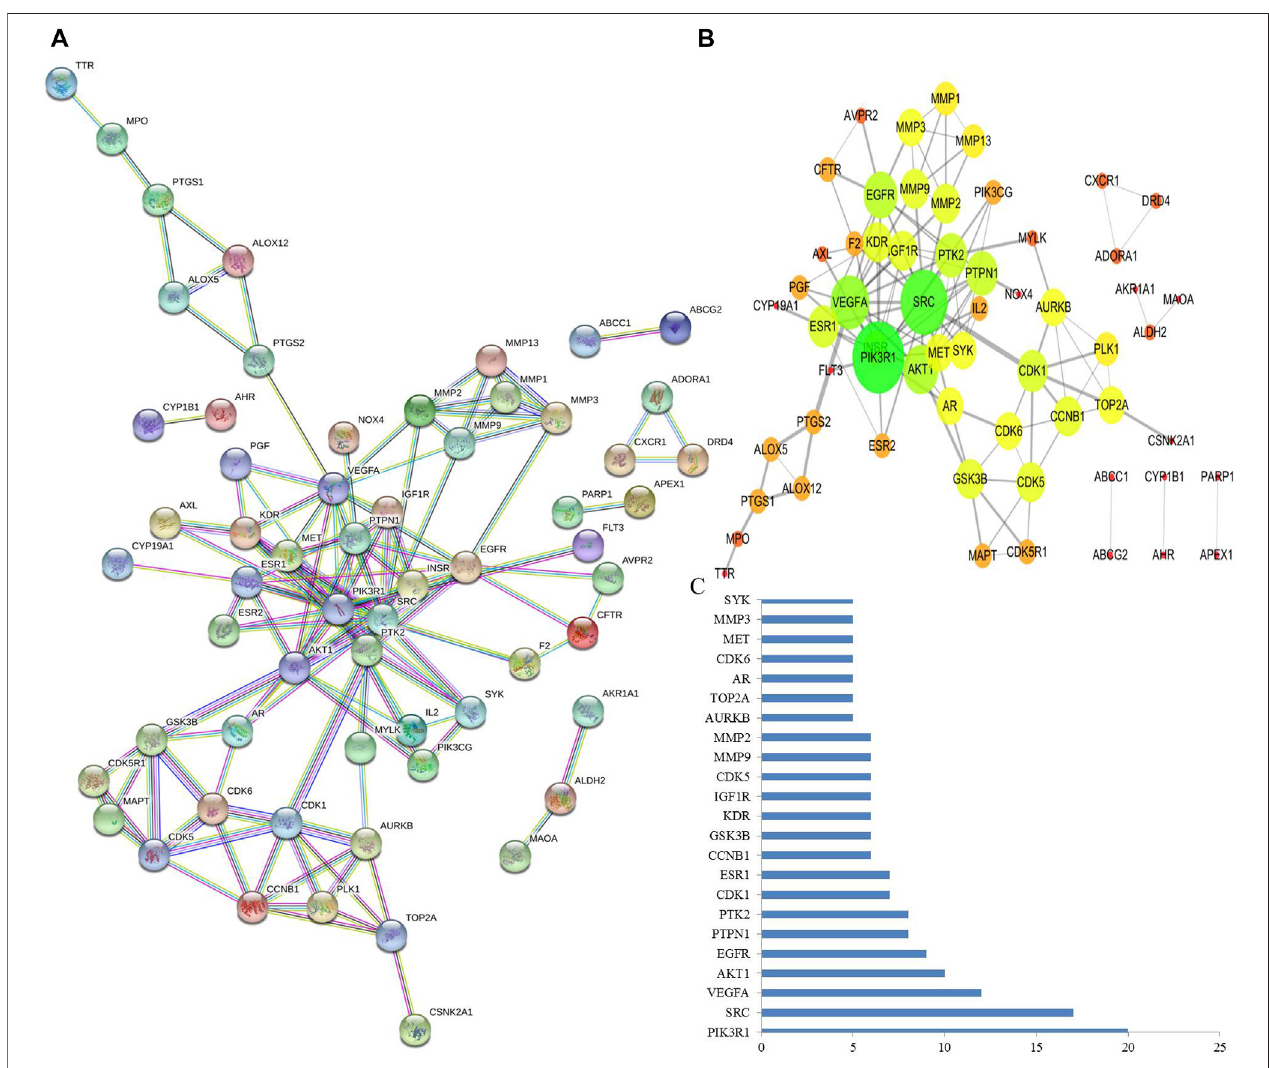
FIGURE 2 | Analysis of PPI networks for protein – protein interactions. (A) Nodes in the network indicated proteins. The empty nodes indicated the unknown 3D structure proteins, and the fi lled nodes indicated known or predicted 3D structure proteins. The edges indicated protein – protein associations. Different colored edges indicated different interactions. (B) The protein – protein interaction was mimicked by Cytoscape software. The size and color of the node indicated the degree value of node, and the thickness of edge represents the combined score. (C) PIK3R1 is probably the most pivotal hub target that was de fi ned as the number of protein – protein associations more than fi